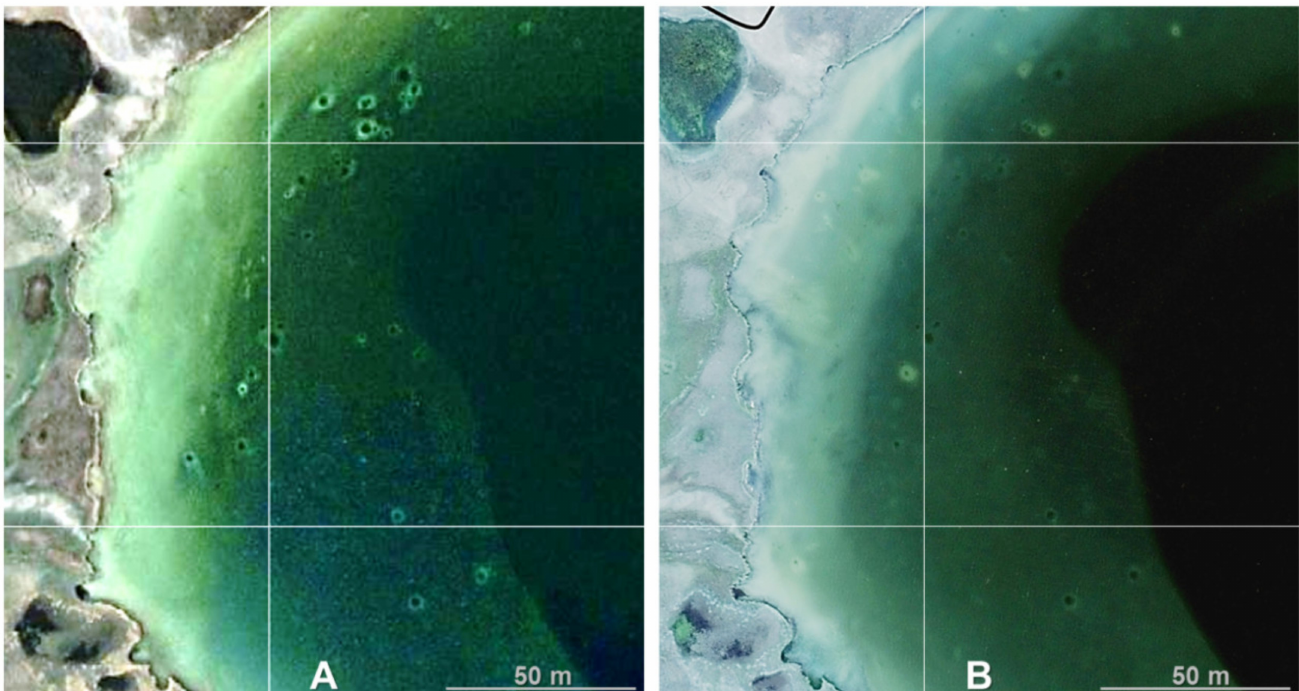
Figure 10. Satellite images of Severo-Seyakhinskoye Lake with craters of gas blowouts on the bottom from WV-2 on 22 June 2013 ( A ) and WV-3 on 27 July 2017 ( B ). The location of the area is shown in Figure